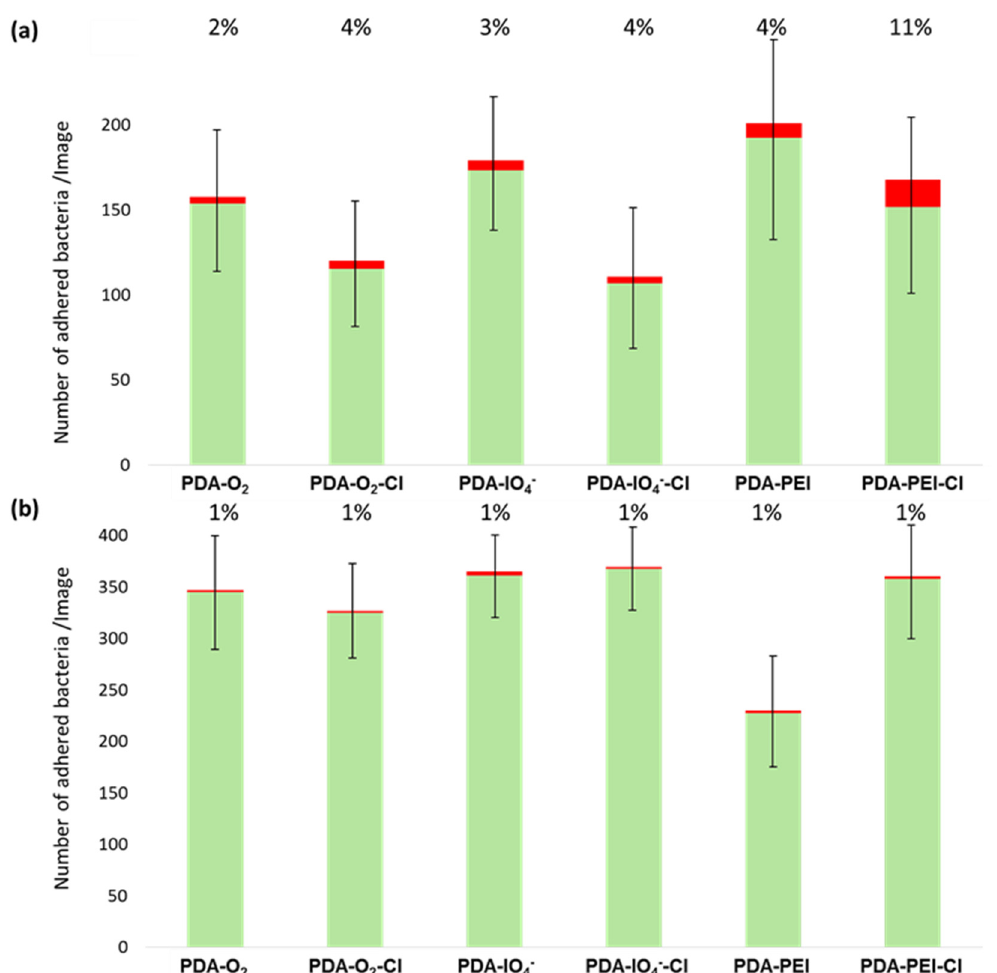
Figure 6. Mean number of adhered bacteria observed by optical microscopy (green bars) and % killing obtained from fluorescence optical microscopy (red bars) for ( a ) E. coli and ( b ) S. epidermidis and for the three PDA coatings before and after chlorination.